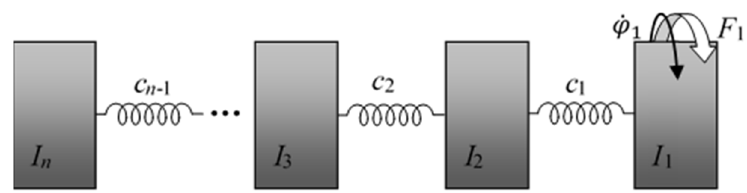
Figure 1. Cascade structure of the free drive system.